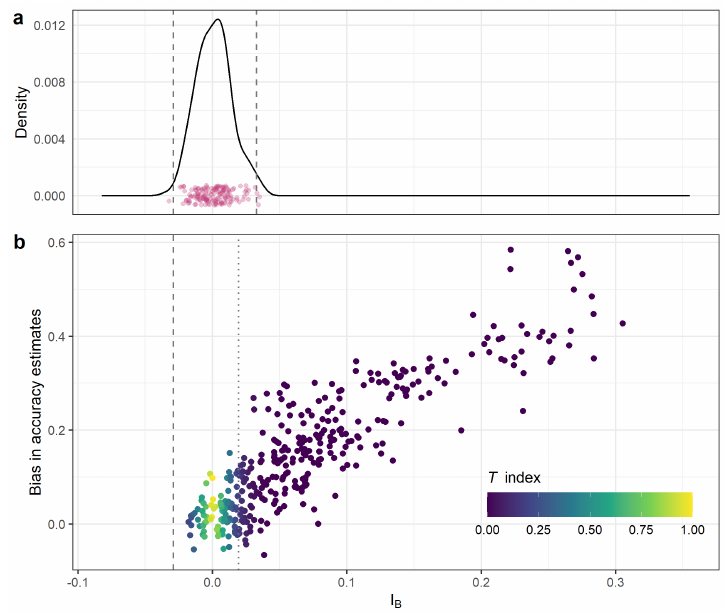
Figure 4. Relationship between Normalised Moran’s I Index ( I B ) and map accuracy. ( a ) Empirical distribution of I B values for random unlabelled data sets. ( b ) Relationship between the I B of the labelled sets, their bias and corresponding T index. There is a strong linear relationship between I B and bias ( y = 0.03 + 1.67 x ; R 2 = 0.79). The dashed line indicates I B values for which the T index is 0.05.